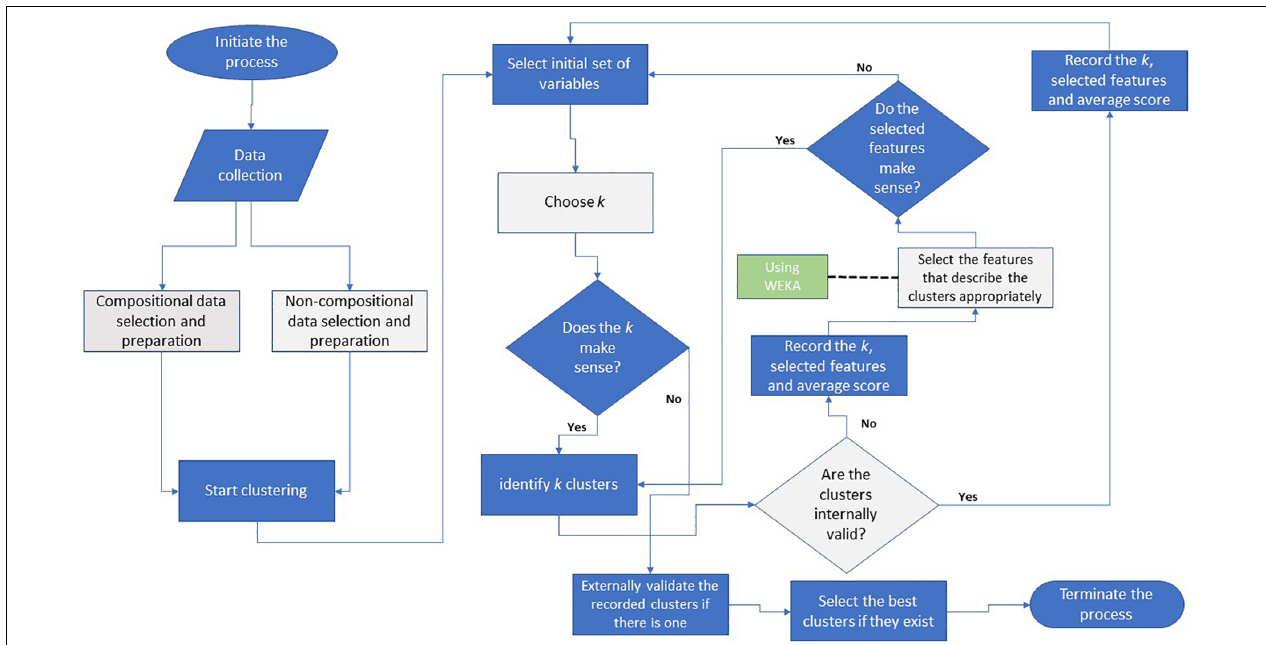
FIGURE 2 | Flowchart of our clustering framework illustrating the inputs/outputs, decisions, and processes undertaken. The light blue shading represents a step we consider novel in our clustering framework. Key: ellipse = start of process; parallelogram = input/output point; diamond = decision point; rectangle = process; oval = end of